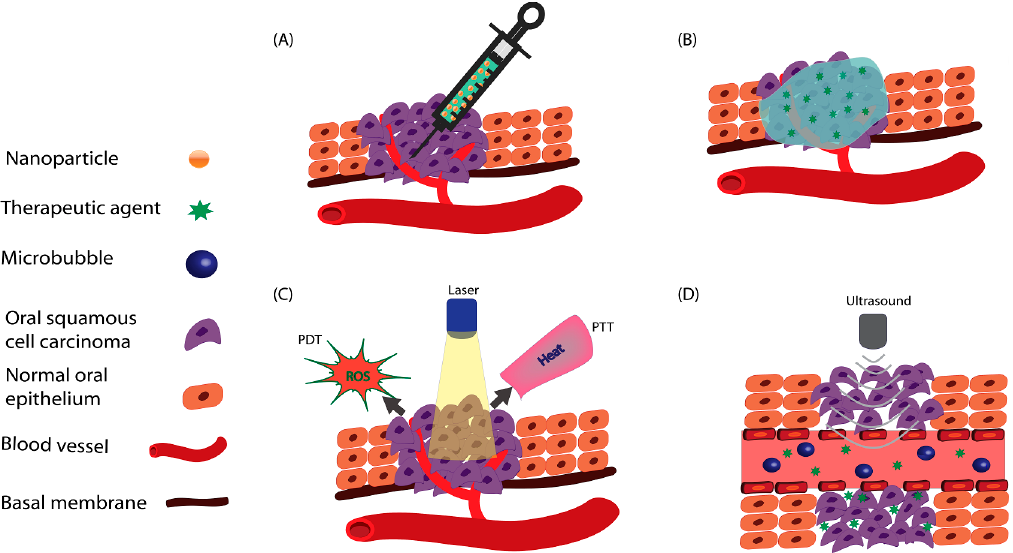
Figure 2. Different controlled drug delivery approaches: ( A ) Intra-tumoral drug delivery; ( B ) local drug delivery; ( C ) photo-thermal therapies combined to drug delivery systems; ( D ) ultrasound- mediated